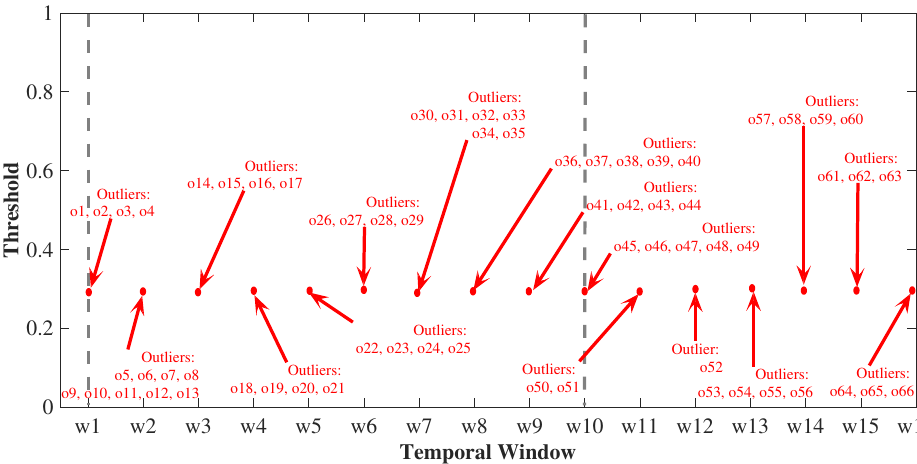
Figure 7. Outliers detection for sliding